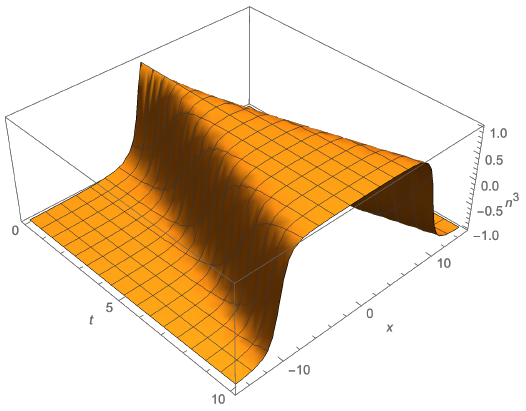
Figure 6 : Value of n 3 as a function of ( t, x ) for A = 1 . Negative values of the radial cylindrical coordinate x correspond to ϕ → − ϕ